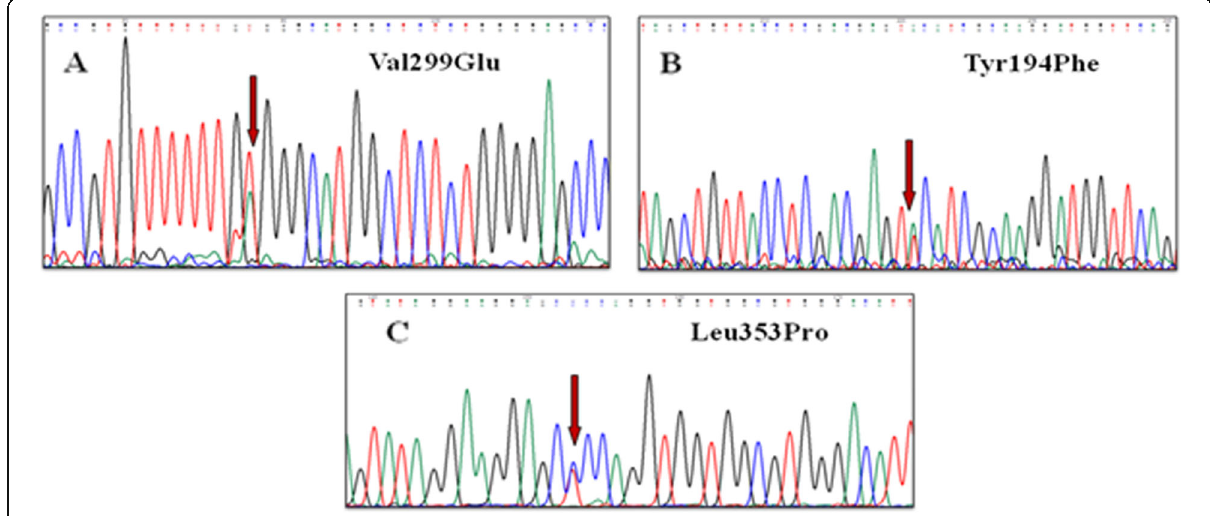
Fig. 2 Electropherogram showing variants identified in Domain 1, ( a ) Val299Glu ( b ) Tyr194Phe ( c ) Leu353Pro, of tuberin protein